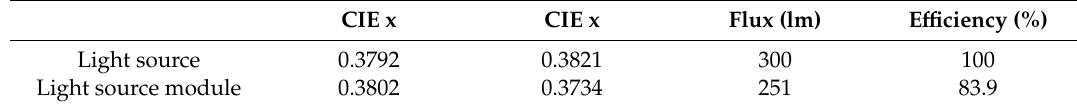
Table 7. Optical characteristics of light source and light source module.